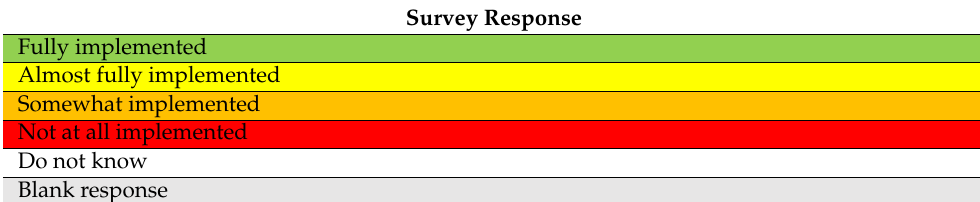
Table 1. Colour coding of Likert scale responses.